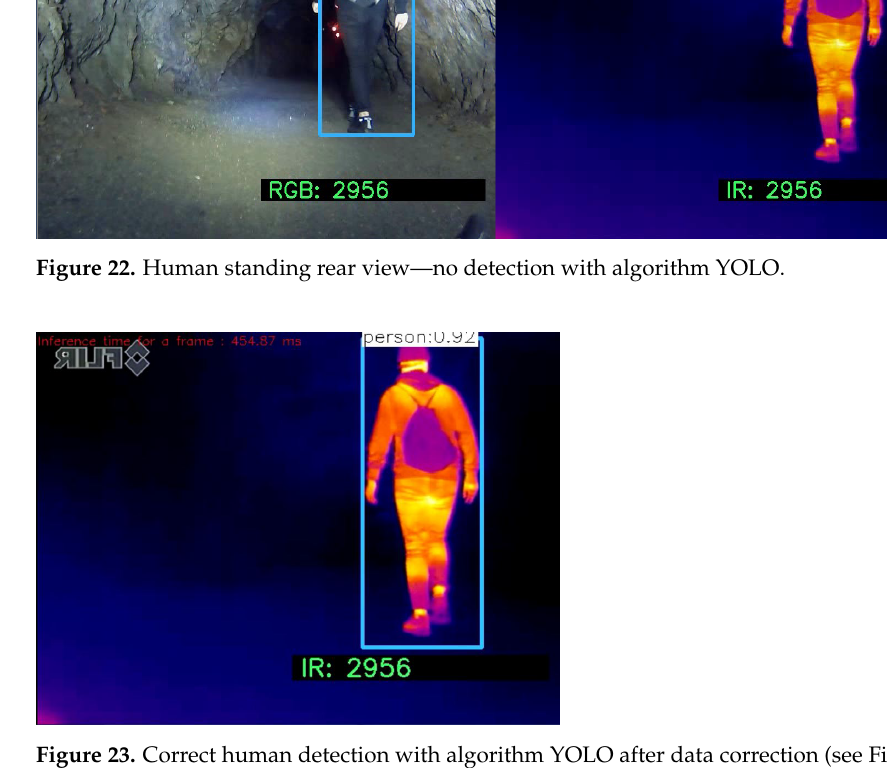
Figure 23. Correct human detection with algorithm YOLO after data correction (see Figure